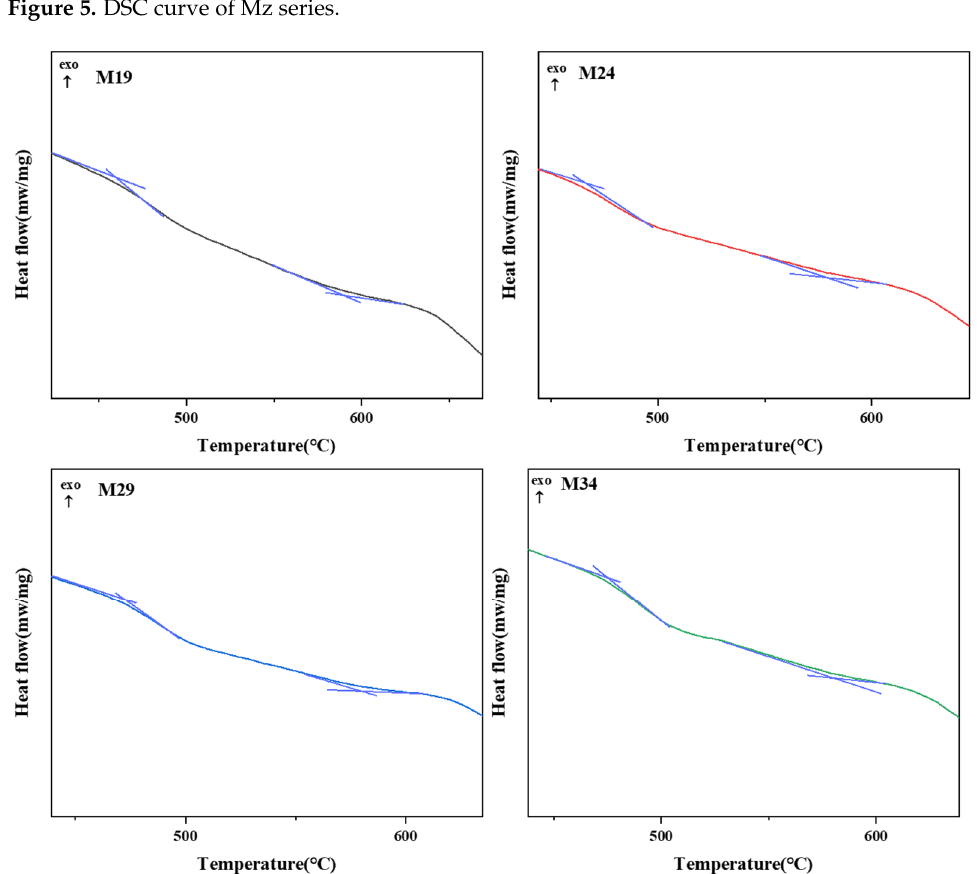
Figure 6. DSC curve zoom area of Mz series.